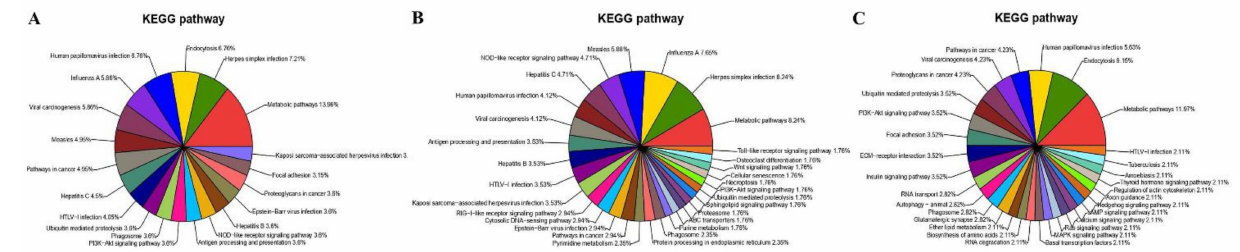
Figure 9. KEGG pathway classification of DEPs in MDBK cells infected with CpHV-1 ( A ), including up-regulated proteins ( B ) and down-regulated proteins ( C ). Each color represents a different KEGG pathway, and the percentages of enriched target protein numbers in each category are displayed in brackets. A detailed representation of the data is provided in Table